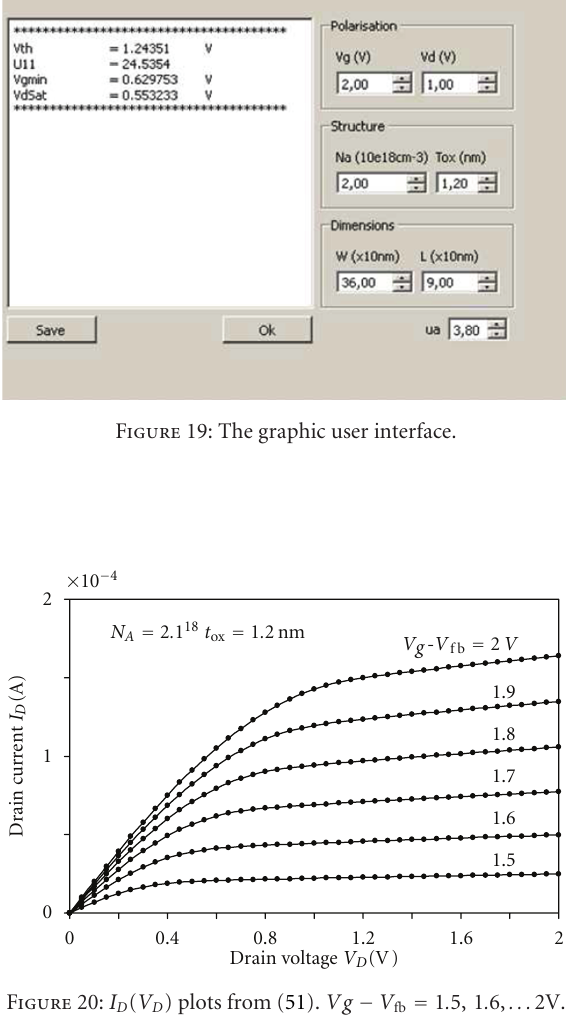
Figure 20: I D ( V D ) plots from (51). Vg − V fb = 1 . 5, 1 . 6, ...